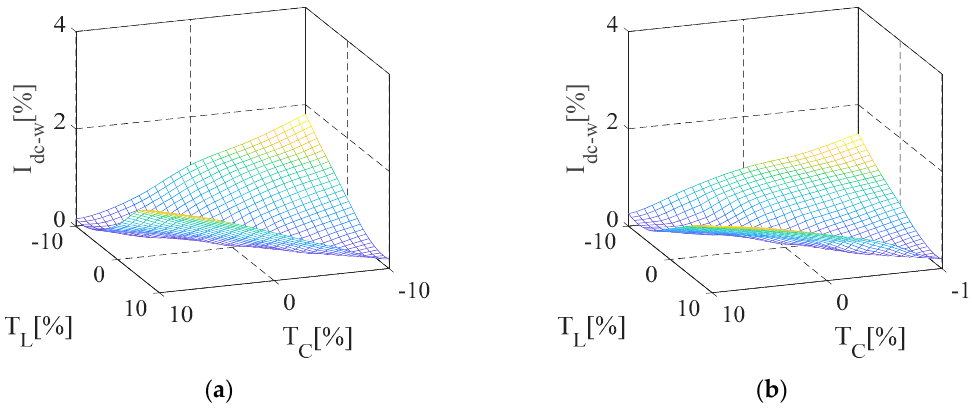
Figure 13. Variation of fundamental frequency dc-link current ripple magnitude (pu) with SM capacitance tolerances T C and arm inductor tolerances T L : ( a ) Scheme-A and ( b ) Scheme-B. Energies 2020 , 13 , x FOR PEER REVIEW